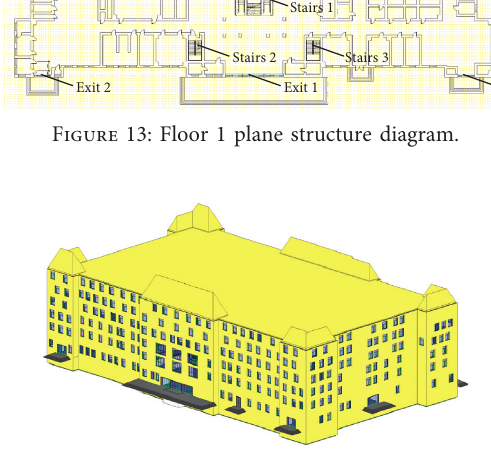
Figure 14: Building information model.